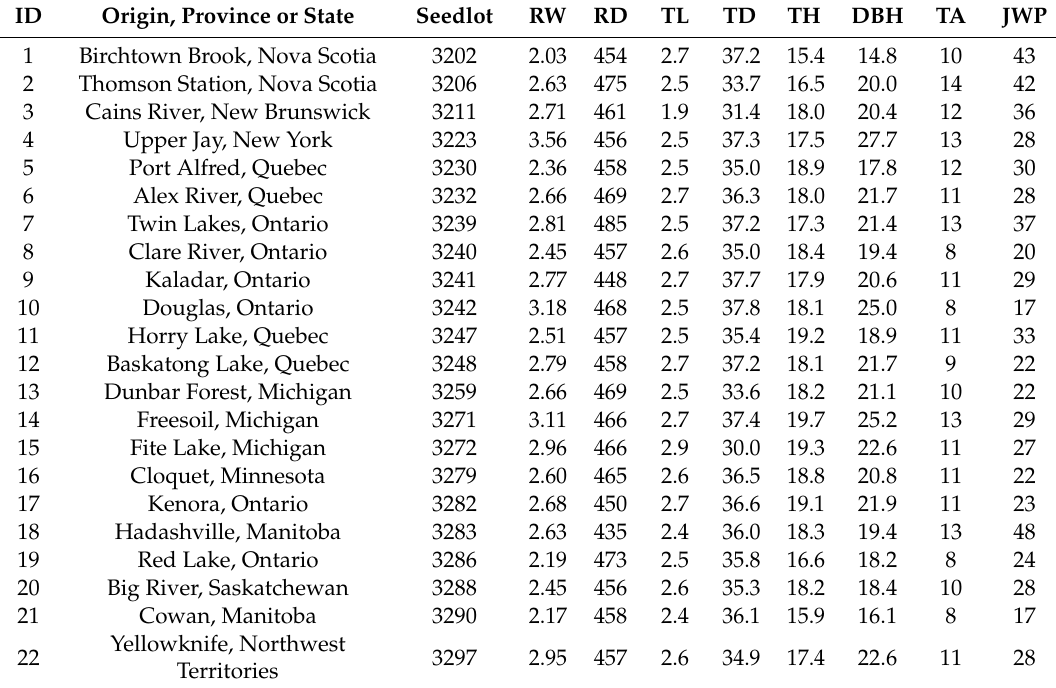
Table 2. Summary of average values of selected wood quality